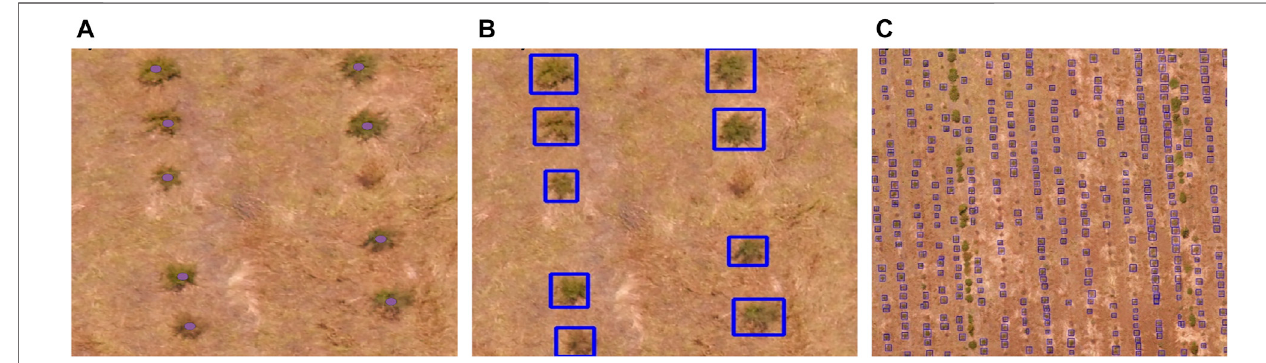
FIGURE6| Accuracyassessment ofUAVimageryand modeltrainingexampleontest set atMooribinsite (A) manually captured shrubs, (B) automatedresultand (C) sample of automated shrub count results.